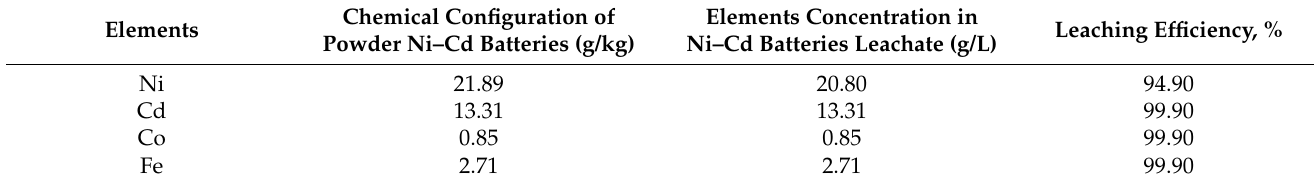
Figure 13. SEM image of Ni–Cd battery powder and a digital photograph of a dismantled spent Ni–Cd battery. Table 7. Chemical composition of consumed Ni-Cd battery